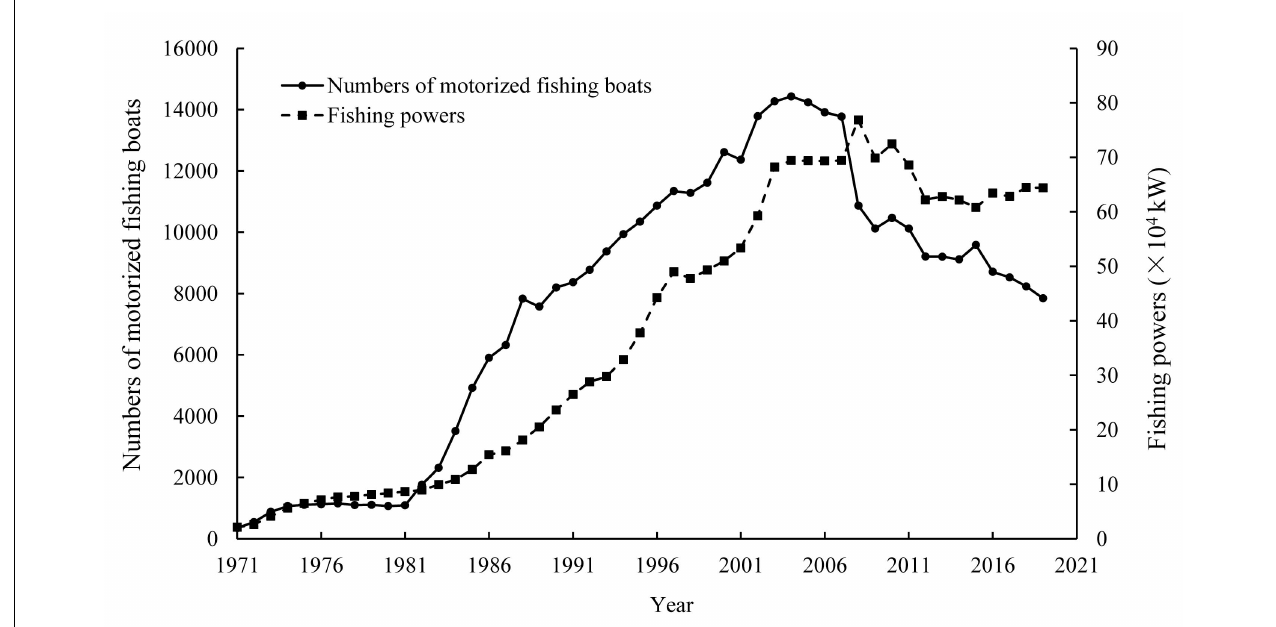
FIGURE 2 | Numbers of motorized fishing boats and total fishing powers of Guangxi